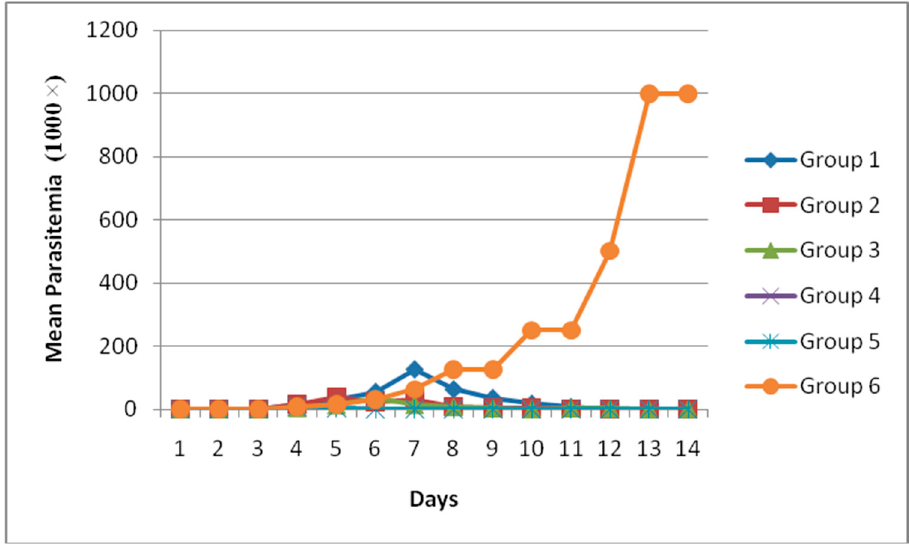
Figure 1. Mean ( n = 2) trypanosome parasitemia of the experimental animals within 14 days. In all 6 groups (2 rats each), parasitemia became visible microscopically 4 days